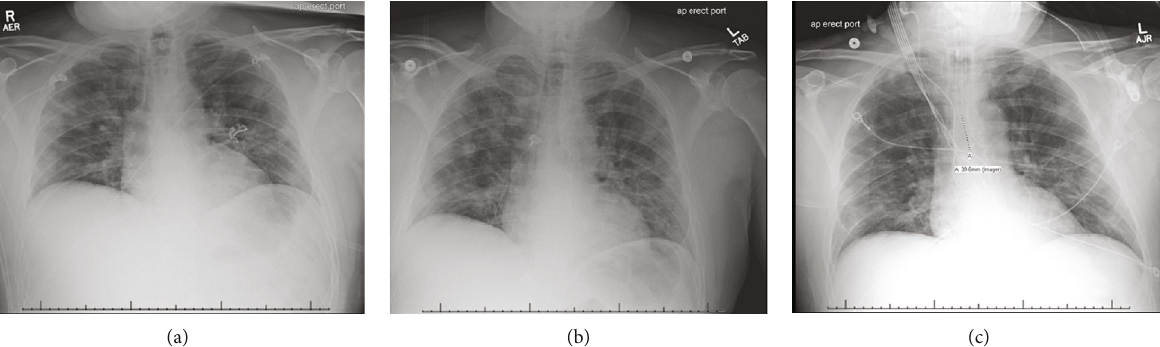
Figure 1: (a) Early chest X-ray (CXR) on day of admission consistent with patchy airspace in fi ltrates concerning for early viral pneumonia. (b) Two days into admission, CXR shows di ff use ground glass and interstitial opacities with worsening airspace in fi ltrates. (c) Decrease in di ff use airspace in fi ltrates and ground glass opacities, six days after